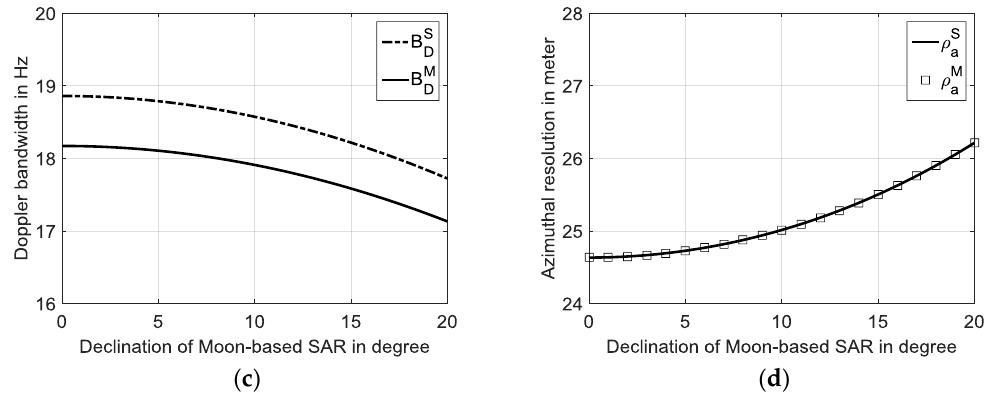
Figure 8. With the increasing ground target latitude, variations of the ( a ) Doppler bandwidth and ( b ) Azimuth resolution. With the increasing declination of the lunar-based SAR, the variations of the ( c ) Doppler bandwidth and ( d ) Azimuth resolution. The superscript S indicates the stationary Moon-Based SAR, while superscript M represents the motional Moon-Based SAR.